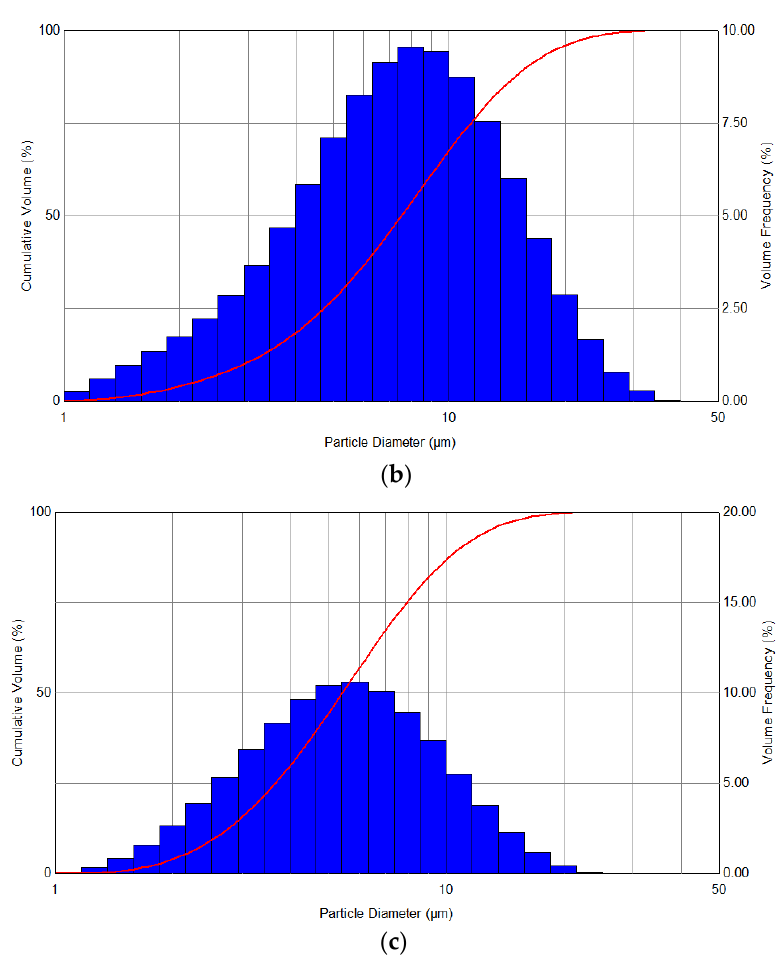
Figure 5. Distribution spectra of the droplet diameters, which were obtained by spraying with a heating power of 100 W and a pressure of ( a ) 1 bar, ( b ) 2 bar, and ( c ) 3 bar.